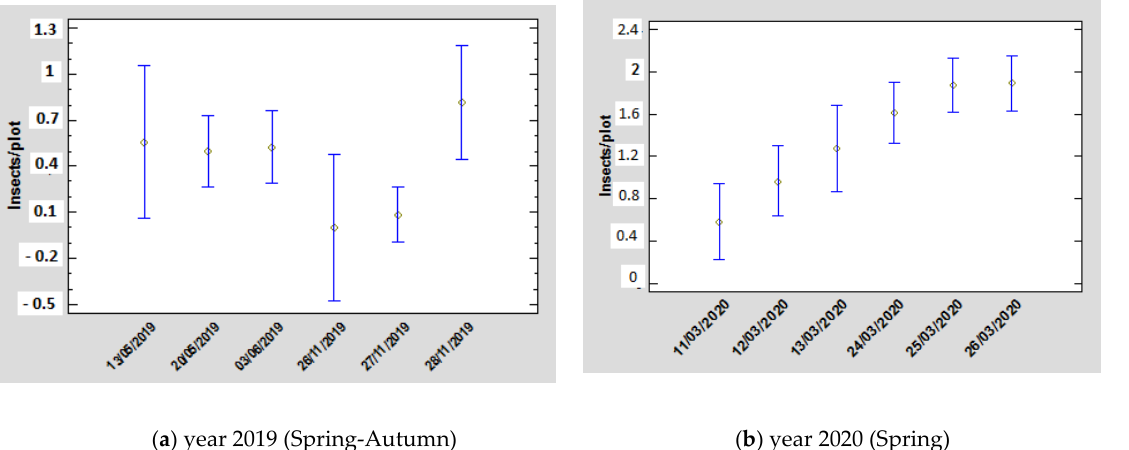
Figure 13. ( a , b ) Mean number of insects per plot with confidence intervals up to 95%, according to the monitoring date. the monitoring